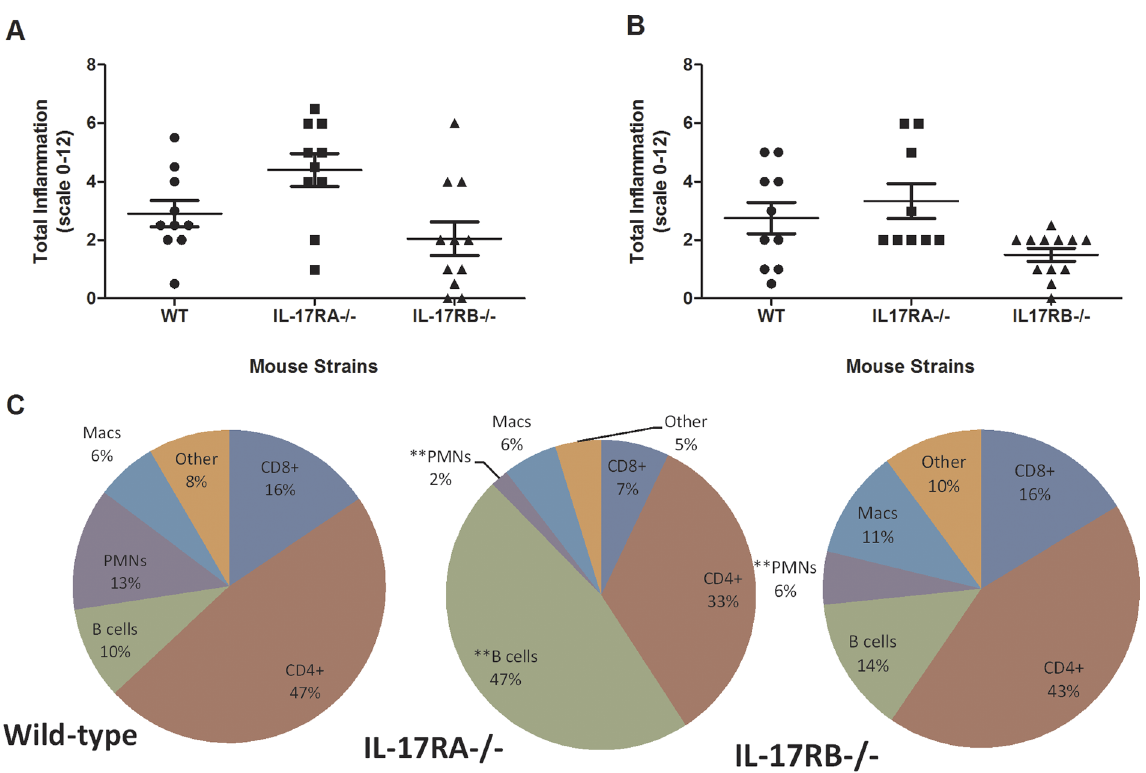
Figure 3. Inflammation is increased in H.pylori -infected IL-17RA 2 / 2 mice compared to H.pylori -infected IL-17RB 2 / 2 and wild-type mice. Levels of acute and chronic inflammation were scored on stomach tissue (in the corpus and antrum) at 2 months (A) and 3 months (B) post infection with strain SS1. Total inflammation was scored on a scale of 0–12. The inflammatory cells were immunophenotyped in the gastric mucosa using flow cytometry (C). The pie charts represent the percentage of specific types of immune cells in the lymphocyte/granulocyte gate. The